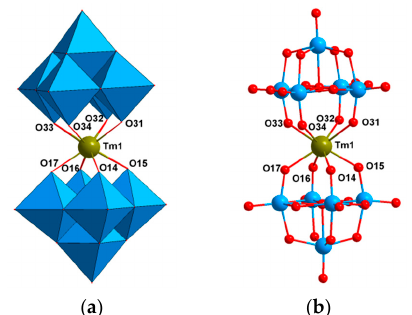
Figure 1. The molecular structure for [Tm(W 5 O 18 ) 2 ] 9 − , 1 : ( a ) Polyhedra and ( b ) ball and stick views. Color scheme: WO 6 = blue polyhedral, W = blue, Tm = bronze and O = red.